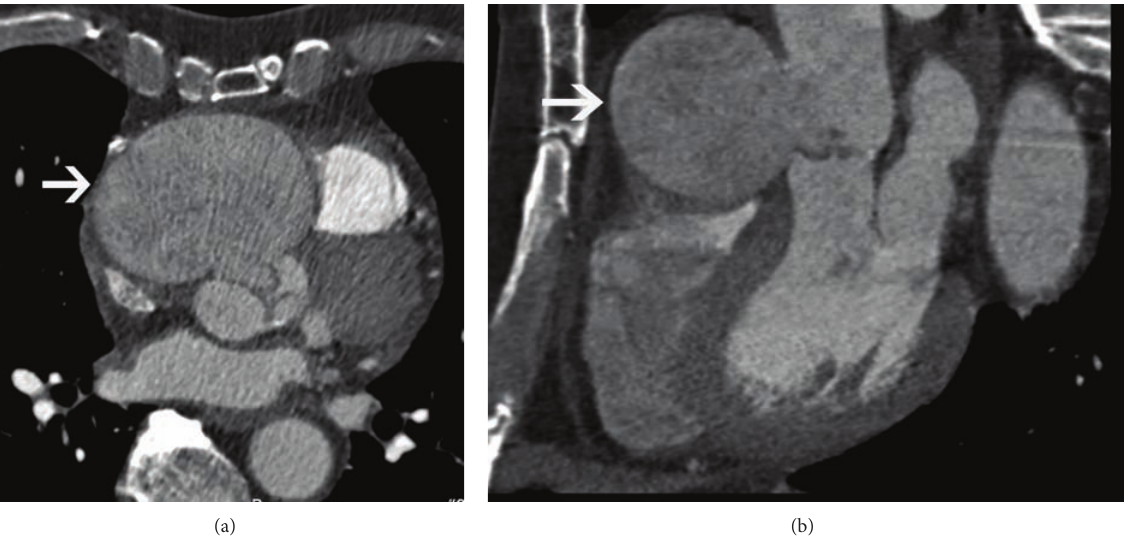
Figure 6: Saccular aortic root aneurysm—(a) short axis reconstructed CT image showing a giant aneurysm of the aortic root, originating from the right sinus of Valsalva. (b) Coronal reconstructed CT image shows the saccular aneurysm with narrow neck originating from the right sinus of Valsalva.